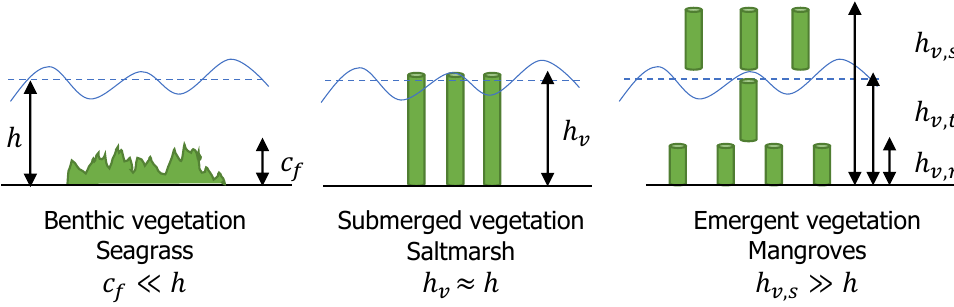
Figure 4. Vegetation schematization: benthic vegetation (seagrasses) as bottom friction, submerged vegetation (saltmarshes) as rigid cylinders and emergent (mangroves) as rigid cylinder with 3 vertical layer schematizations. See nomenclature in appendices for variables’